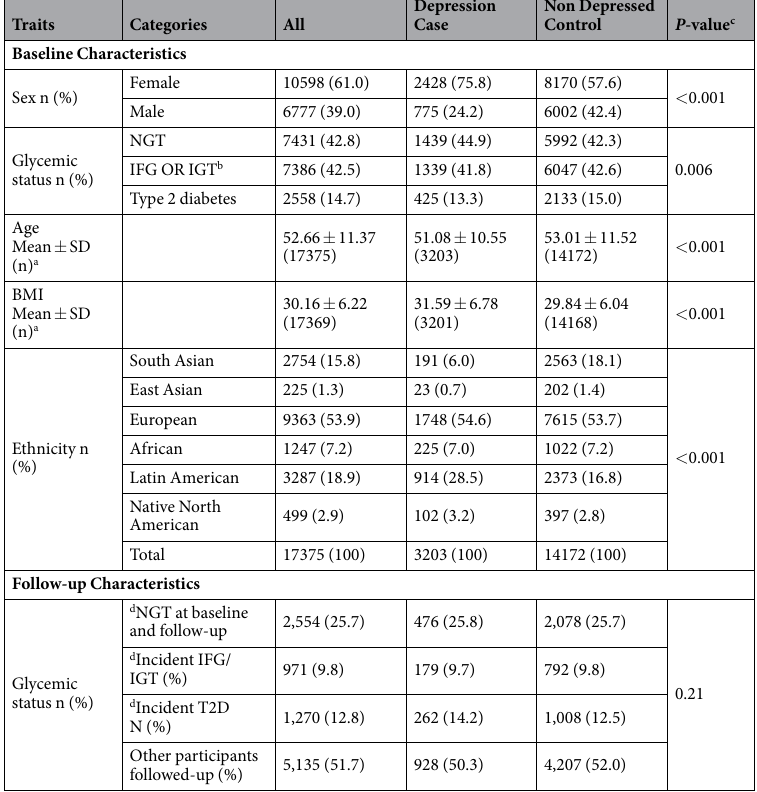
Table 1. Baseline and follow-up characteristics by depression status in the EpiDREAM study. a SD = standard deviation. b NGT = normal glucose tolerance; IFG = impaired fasting glucose; IGT = impaired glucose tolerance. c P are reported for unadjusted univariable analyses (Chi-square or Student T-tests. d Glycemic status based on